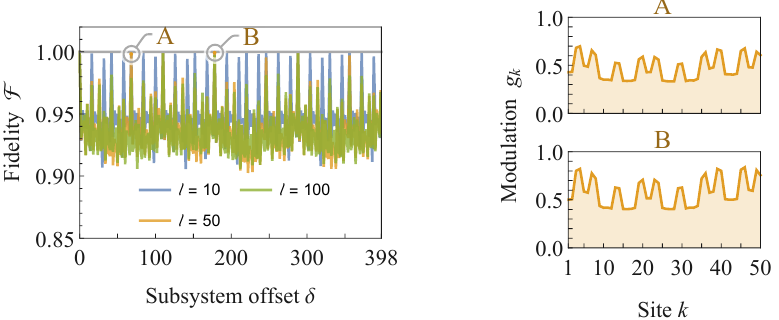
Figure 10 . Approximate translation invariance of a subsystem of l values of the disorder vector g on N = 597 total sites (figure 8, top left) with another subsystem at offset δ . The fidelity F between both subsystems of g is shown on the left for three different subsystem sizes, with two examples subsystems A and B with fidelity close to 1 shown on the